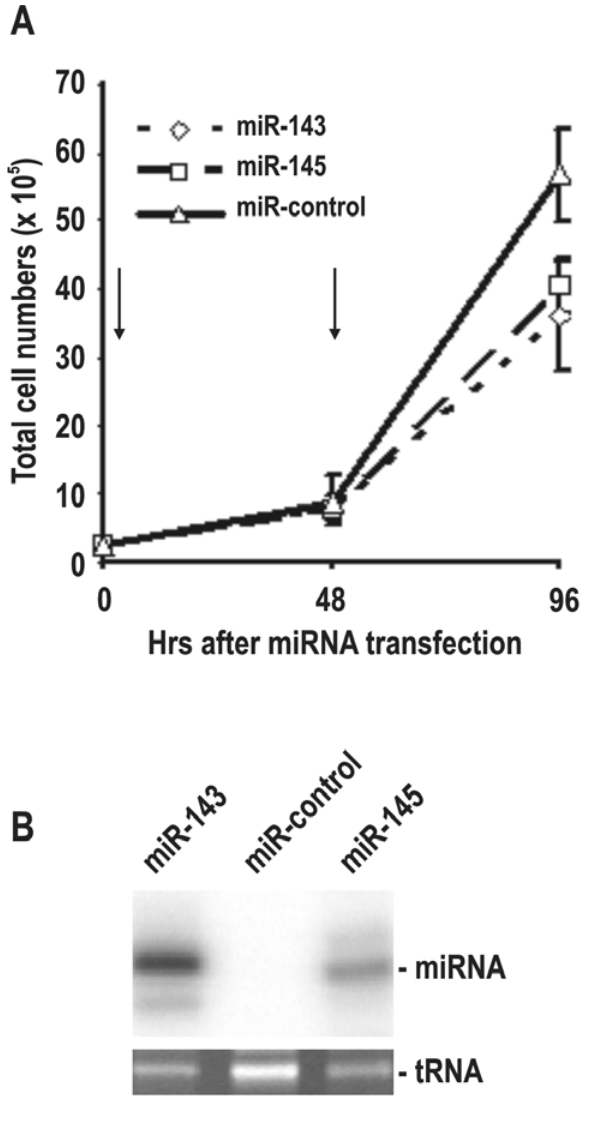
Figure 6. Overexpression of miR-143 and miR-145 suppresses HeLa cell growth. A . miR-143 and miR-145 are suppressive for HeLa cell growth. Arrows indicate the time points when the cells received a specific miRNA (30 nM) transfection. Viable cells in each group were counted at the indicated time points. Data represent the mean 6 SD of two experiments, each performed in triplicate. B . Relative levels of miR- 143 and miR-145 in HeLa cells at 96 hrs after first transient transfection. Total cell RNA extracted was examined by miRNA ligation assay. A tRNA level in each sample was used as a loading control. (Fig. 2A and 2B) in northern blot analyses. Our findings are consistent with other reports obtained from biochemical analyses that Dicer uses a 3 9 end counting rule and measures a distance of , 22 nt from the 3 9 -terminus to cleave both strands of RNA, with 1- to 2-nt shifts in the preferred cleavage position [18,66].